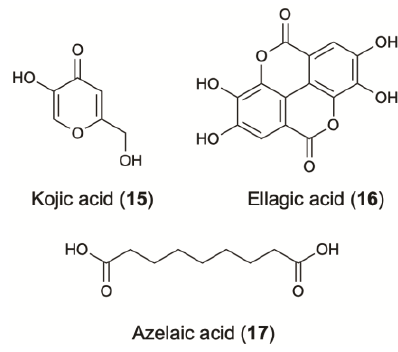
Figure 4. Skin-whitening agents from terrestrial microorganisms.